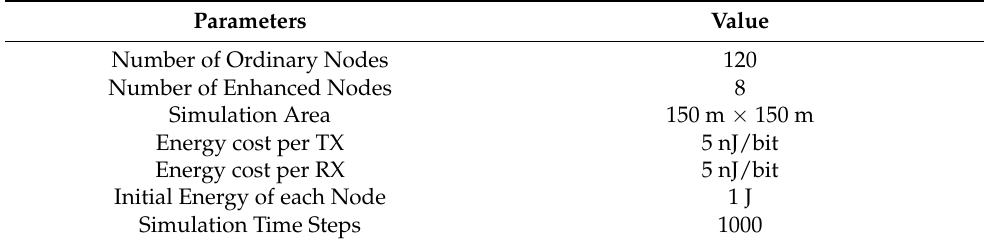
Table 4. Simulation parameters and